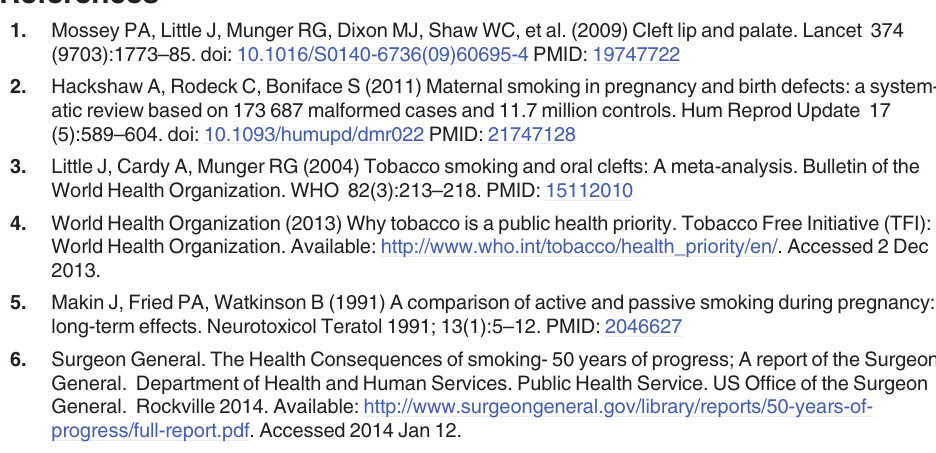
S1 Fig. Search strategy for systematic review assessing the relationship between passive smoking and non-syndromic oral cleft. S2 Fig. Quality table and coding manual. S1 Table. Data extraction